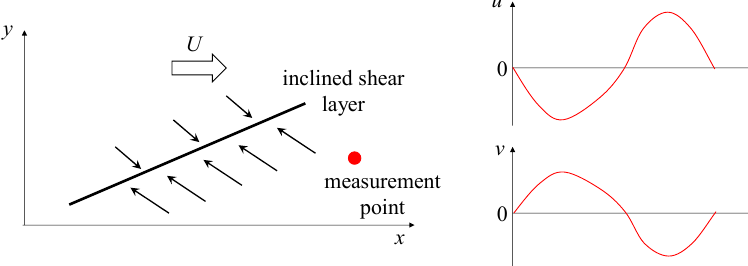
Figure 4. The explanation of the phase angle in the wavelet coherency between the streamwise and vertical velocity series at the same measurement point when the incline structures pass. When the hairpin packet passes the measurement point, the Q2 events lead to that the streamwise fluctuation u appears in positive firstly, and the vertical fluctuation v appears in negative. After the inclined shear layer passes the measurement point, u and v turn into negative and positive, respectively.